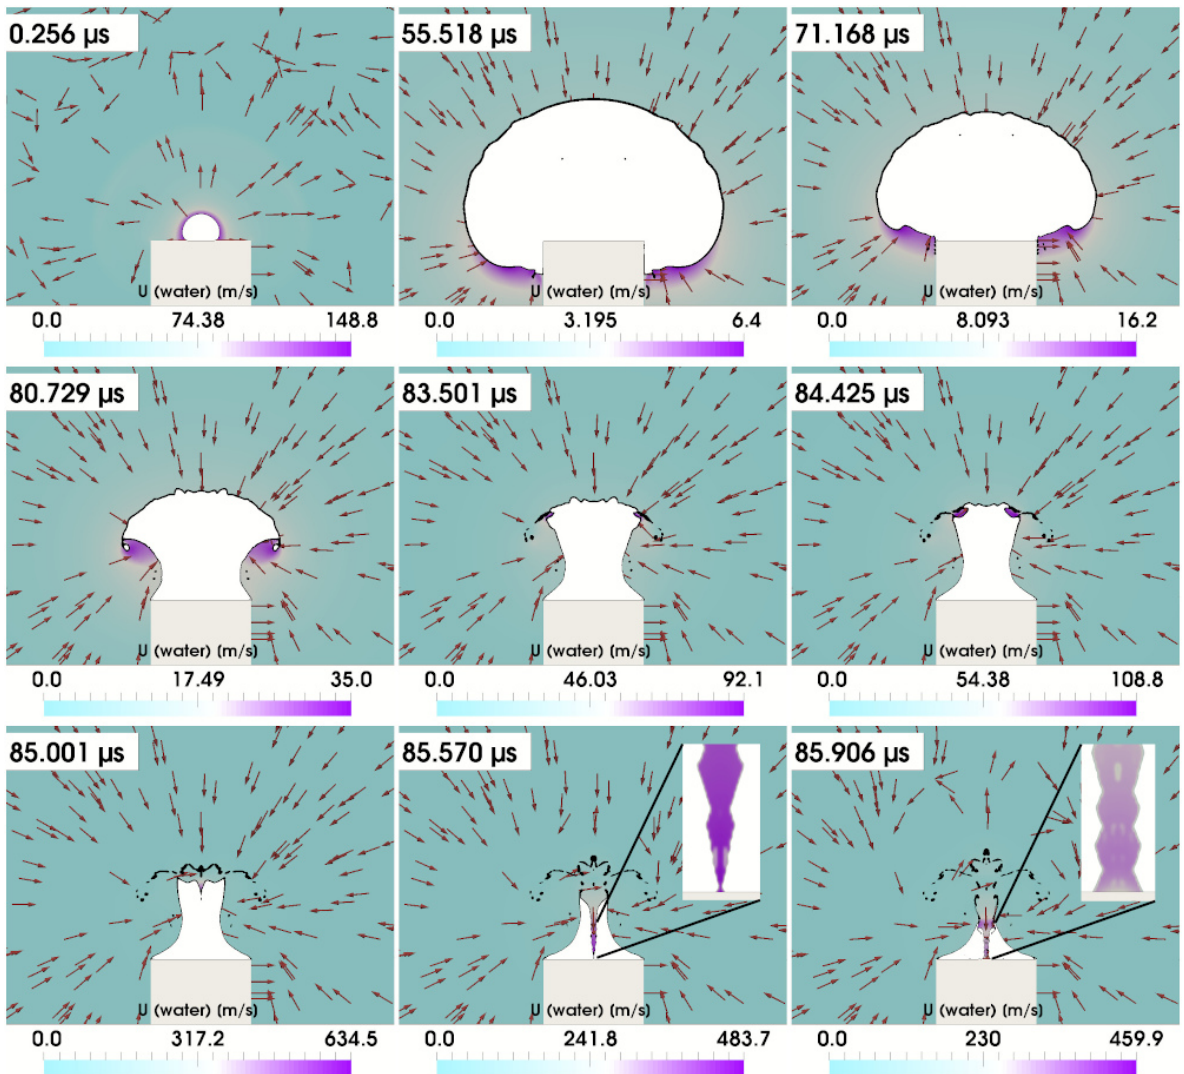
Figure 11. Simulation results for the velocity U of the same bubble and cylinder as in Figure 10. In the first frame (upper left frame), it is seen that the shock wave from bubble initiation induces an outward flow ahead of the expanding bubble surface. The last two frames contain a zoom inset into the region of maximum velocity (the fast jet). In the insets the velocity arrows are omitted for the sake of visibility. Cylinder radius is 200